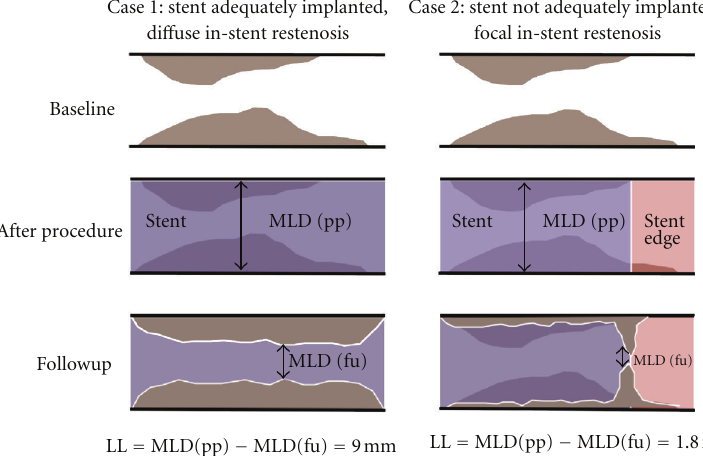
Figure 2: Late loss without association to the true extent of neointimal hyperplasia. Case 2 has a significant higher late loss, due to inade- quately implanted stent (purple) at distal stent-edge (red) than case 1, although significant more di ff use neointimal hyperplasia is present in case